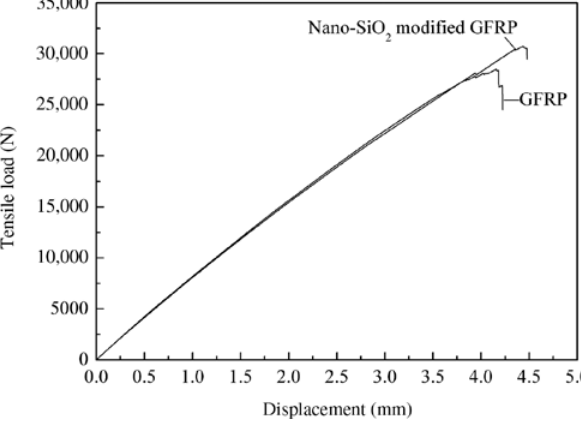
Figure 3: Typical load-displacement curves of the GFRP and nano- SiO modified GFRP under the tensile load condition. 2